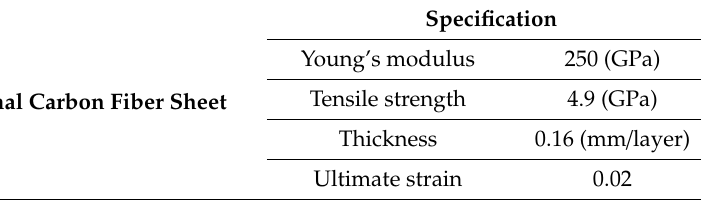
Table 3. Material properties of the uni-directional carbon fiber sheet (12 k, FAW = 300 g / m 2 ).